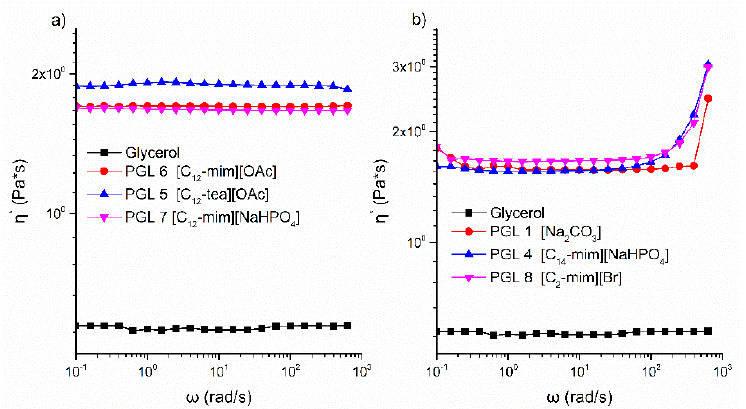
Figure 9. Graph of the dependence of the complex viscosity on the angular frequency of shear at 30 ◦ C for the obtained oligoglycerols with the use of ionic liquids ( a ) Newtonian liquids ( b ) non-Newtonian liquids.